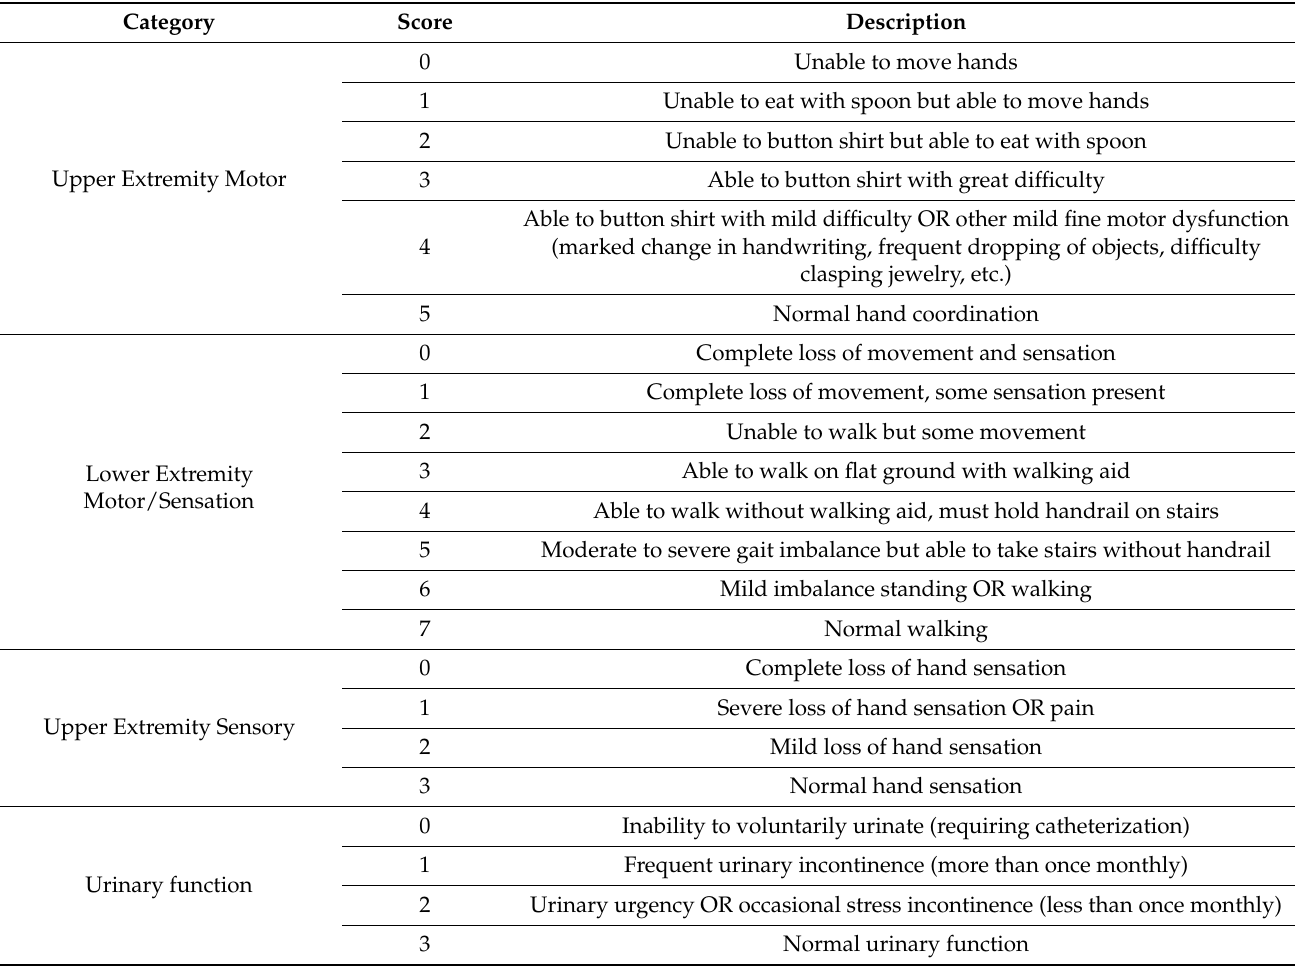
Table 1. The modified Japanese Orthopaedic Association (mJOA) Score (adapted from [21]).